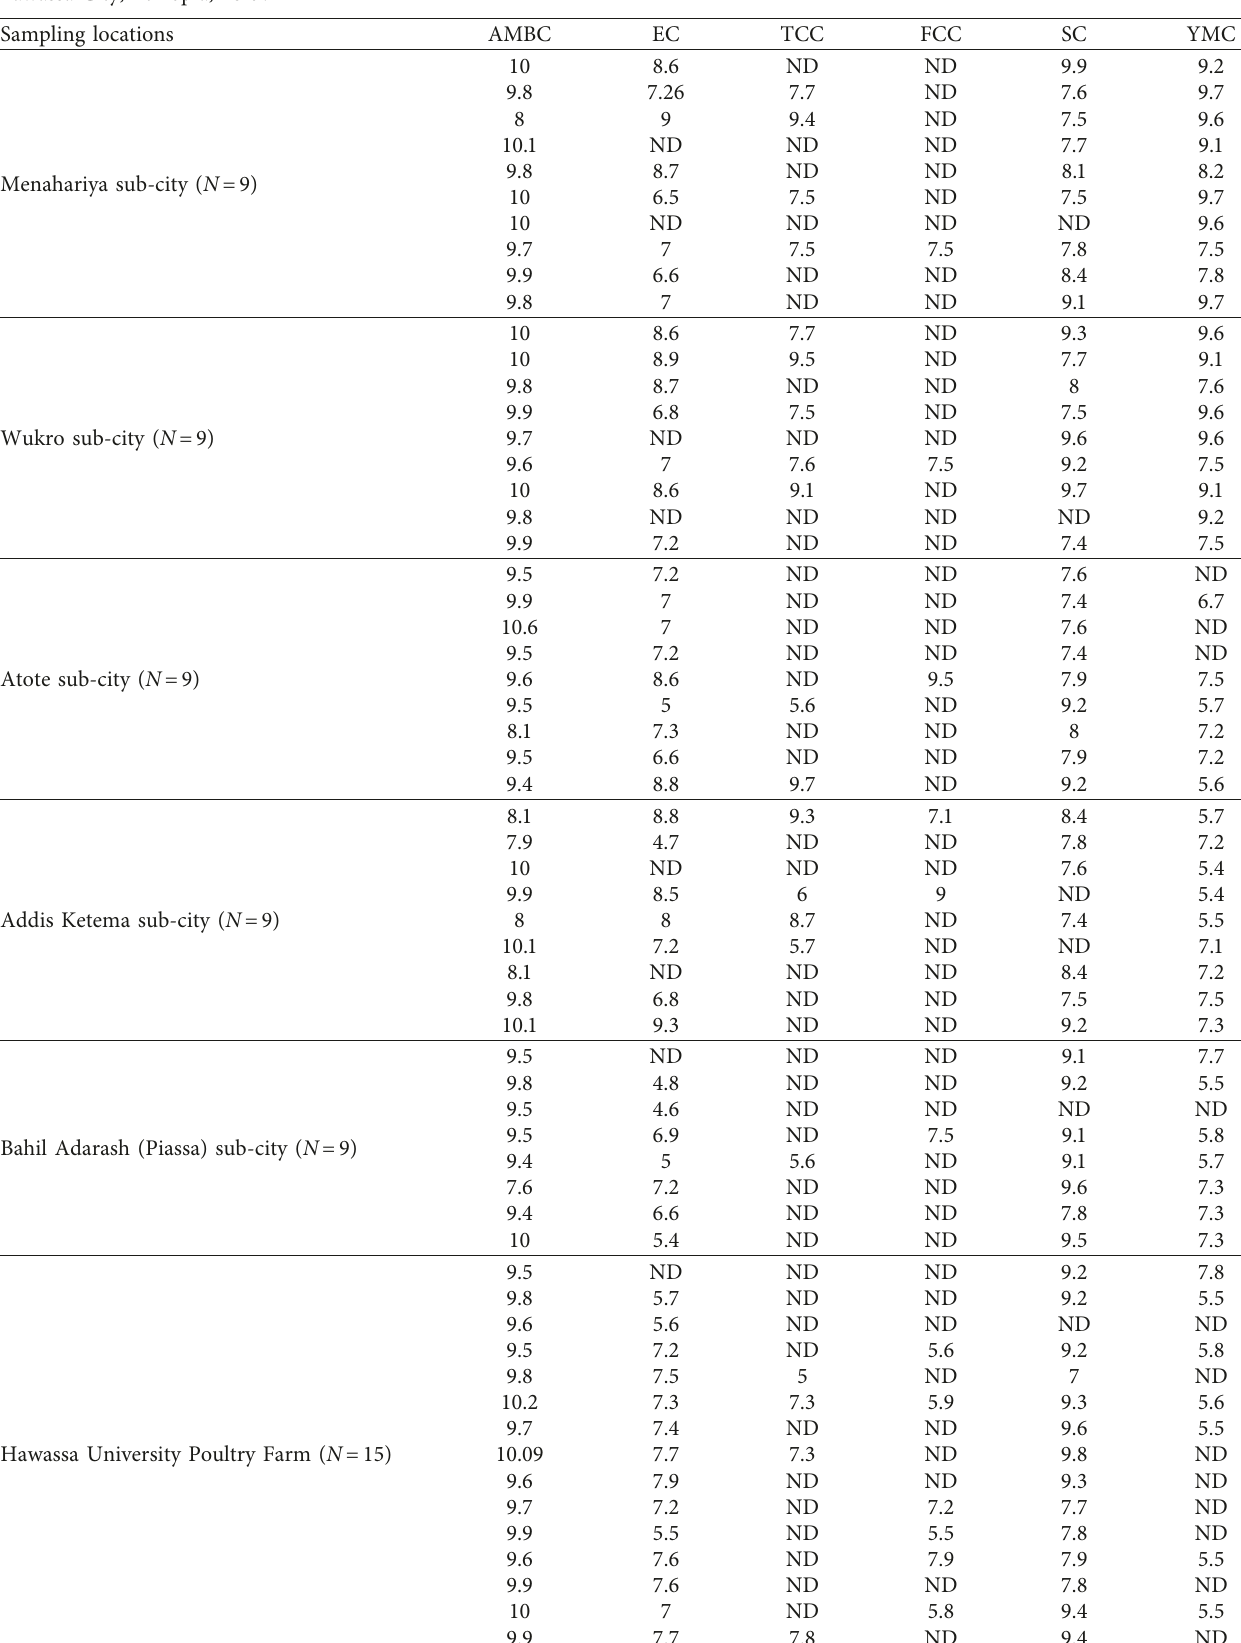
Table 3: Average microbial loads in log 10 CFU/ml of the shell surface rinsate of chicken egg samples collected from six different locations in Hawassa City, Ethiopia, 2019. Sampling locations AMBC EC TCC FCC SC YMC